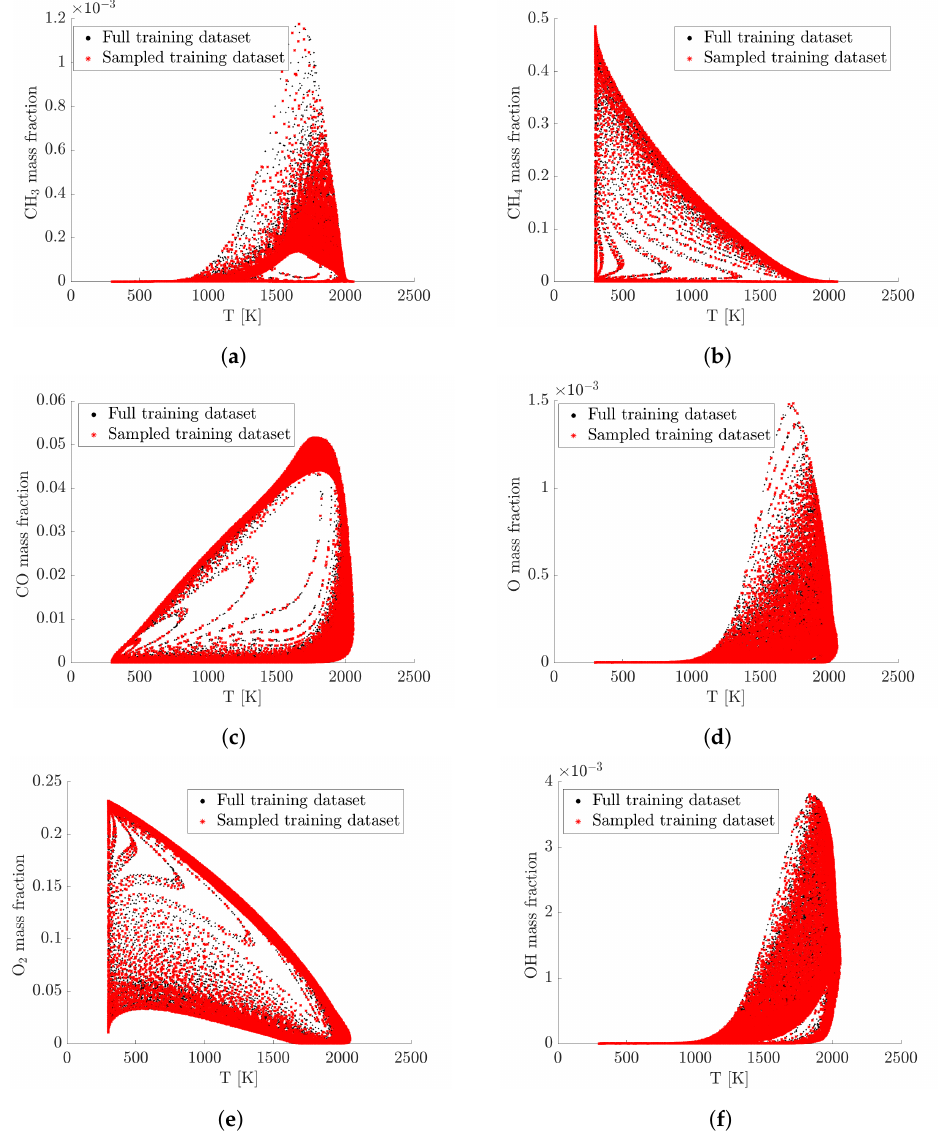
Figure 3. Comparison of the accessed thermochemical space by the full (black dots) and the sampled (red cross) training dataset for: ( a ). CH 3 mass fraction; ( b ). CH 4 mass fraction; ( c ). CO mass fraction; ( d ). O mass fraction; ( e ). O 2 mass fraction; ( f ). OH mass